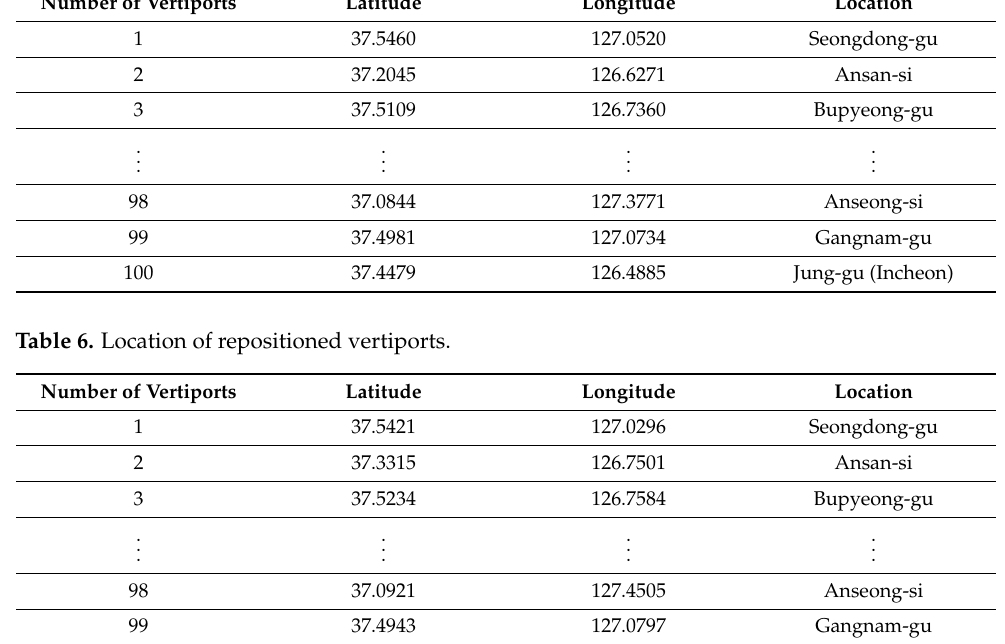
Table 5. Location of vertiports when the number of vertiports is 100.